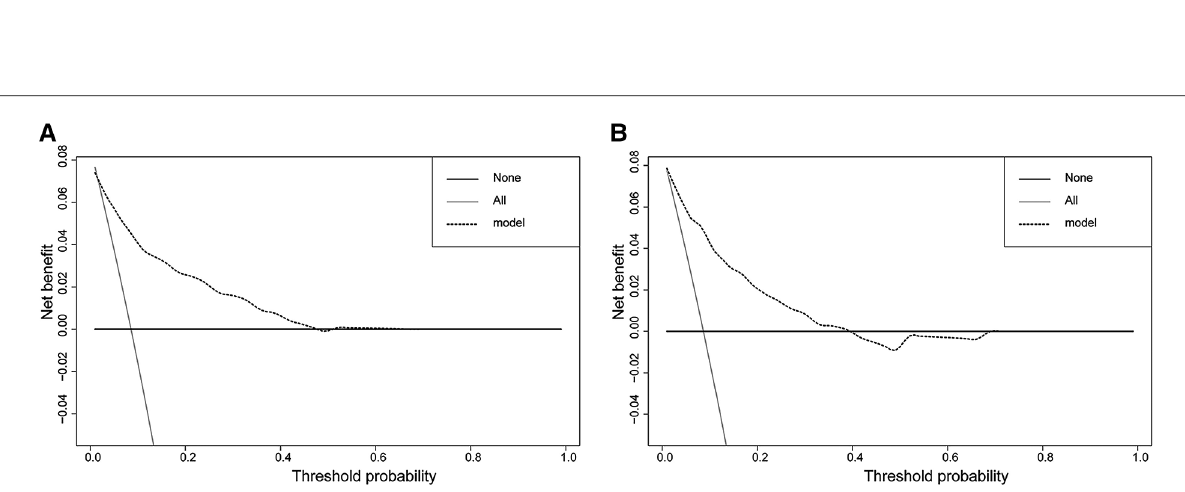
FIGURE 5 Decision curves of the nomogram. ( A ) The training cohort; ( B ) the validation cohort. The horizontal solid black line represents one extreme situation in which none of the patients experienced DM, and the solid gray line indicates the other extreme situation in which all patients experienced DM. The dotted black line represents the prediction of the nomogram model; the farther away from the above two lines it is, the greater the clinical